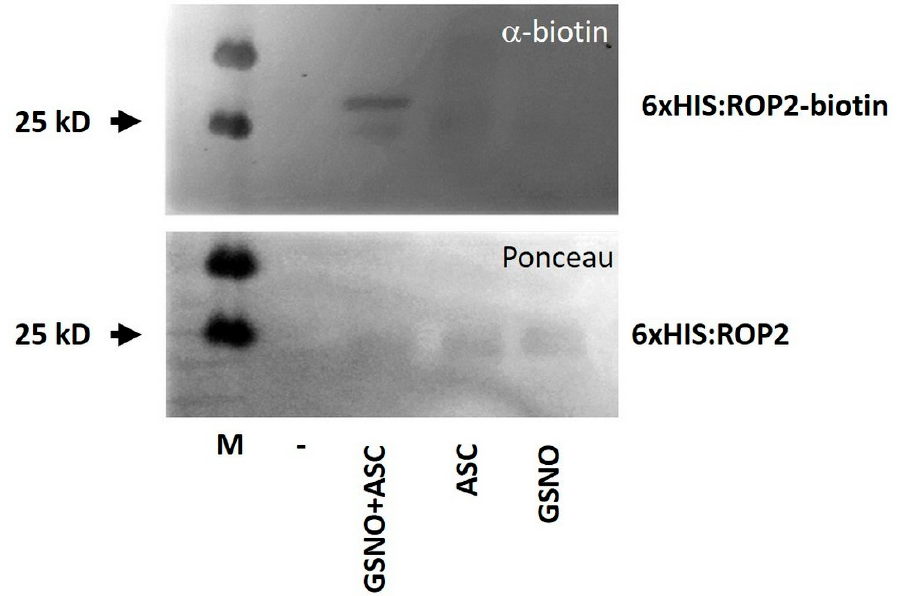
Figure 2. In vitro S-nitrosation of GSNO-treated 6xHIS:ROP2 protein as analyzed by Western blotting using an anti-biotin antibody ( α -biotin) following the “biotin switch” method (upper picture). The absence of ascorbate (Asc) served as negative control. Ponceau S staining is shown as loading control (lower picture). M—molecular mass standard.